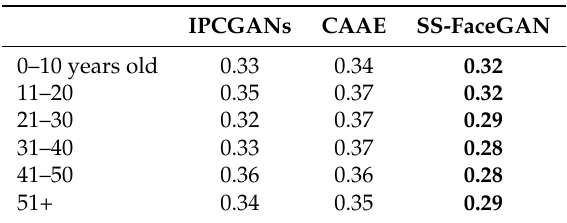
Table 1. The cosine similarity scores with different